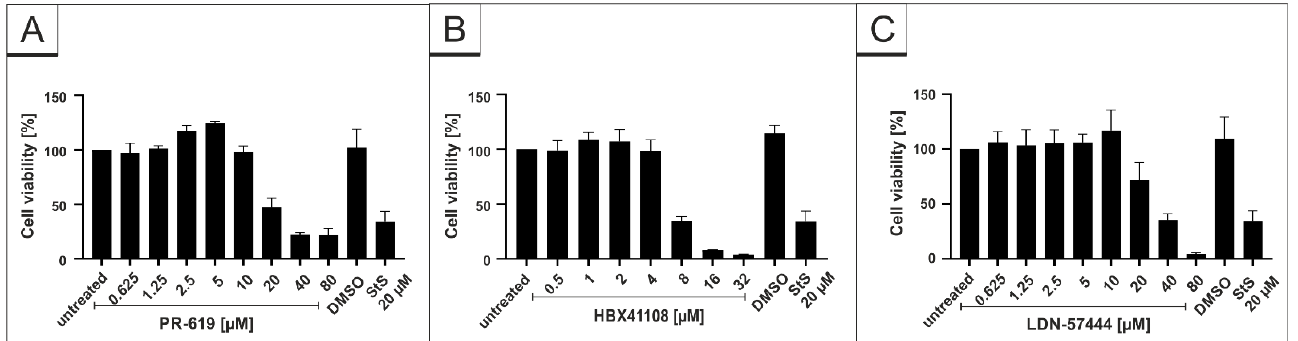
Figure 6. Influence of PR-619, HBX41108 and LDN-57444 on cell viability in Calu-3 cells. Following treatment with ( A ) PR-619, ( B ) HBX41108 and ( C ) LDN-57444 for 30 h, the cell viability was measured by water-soluble tetrazolium salt (WST)-1 assays. Bars represent mean values of three independent experiments ± SD. Staurosporine (StS).